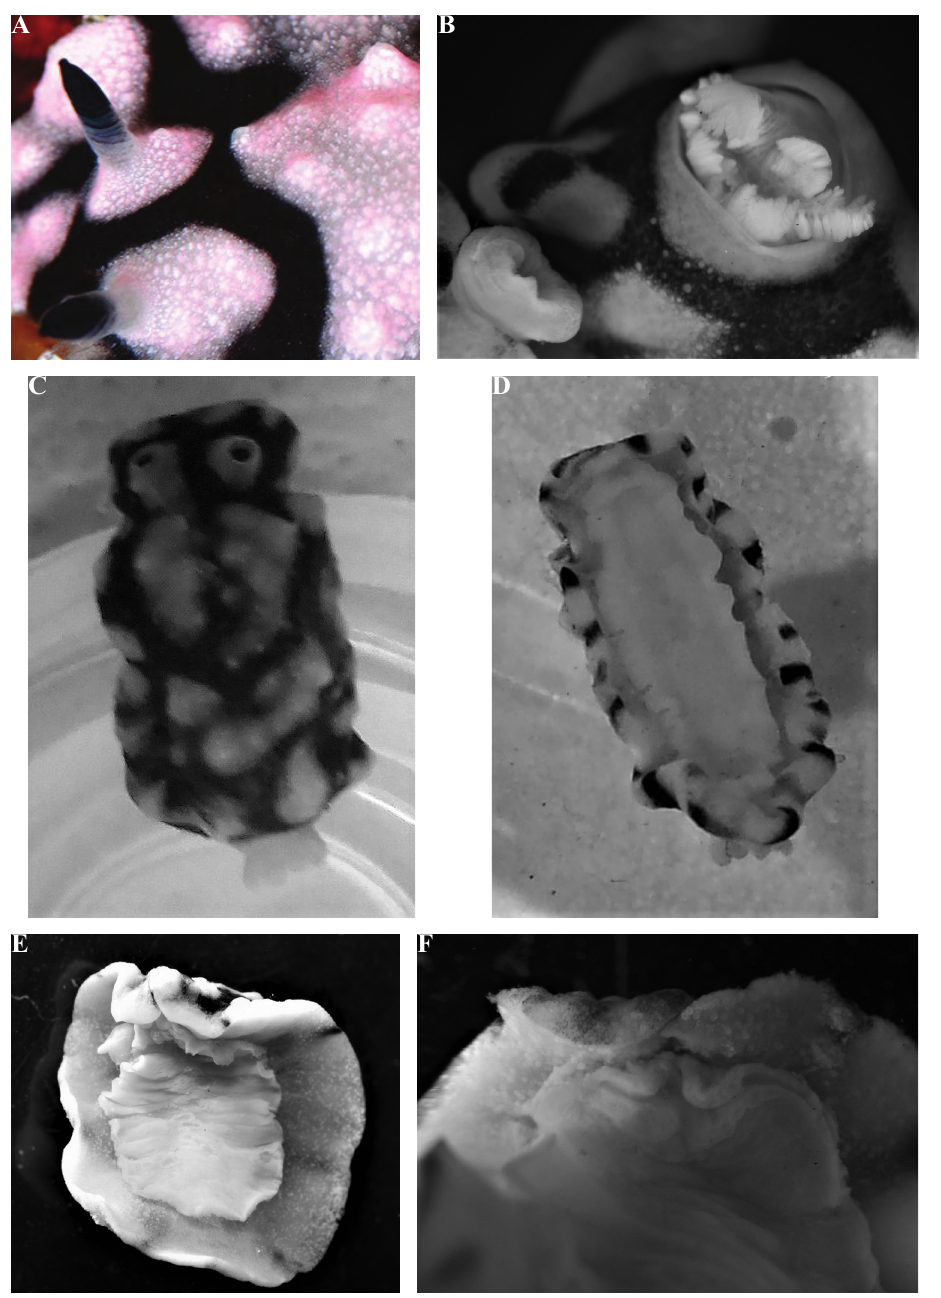
Figure 9. Paradoris hypocrita sp. nov. A detail of the granulation of the pink areas and the tubercles (pho- tograph only, Hsini Lin LIN-0805) B gills partially extended, preserved paratype SMF 360587 C dorsal view showing extended gills, preserved holotype SMF 360586 D ventral view of preserved holotype SMF 360586 E ventral view of specimen A SMF 360589 with penis extruded F anterior bilabiate foot margin of specimen B SMF